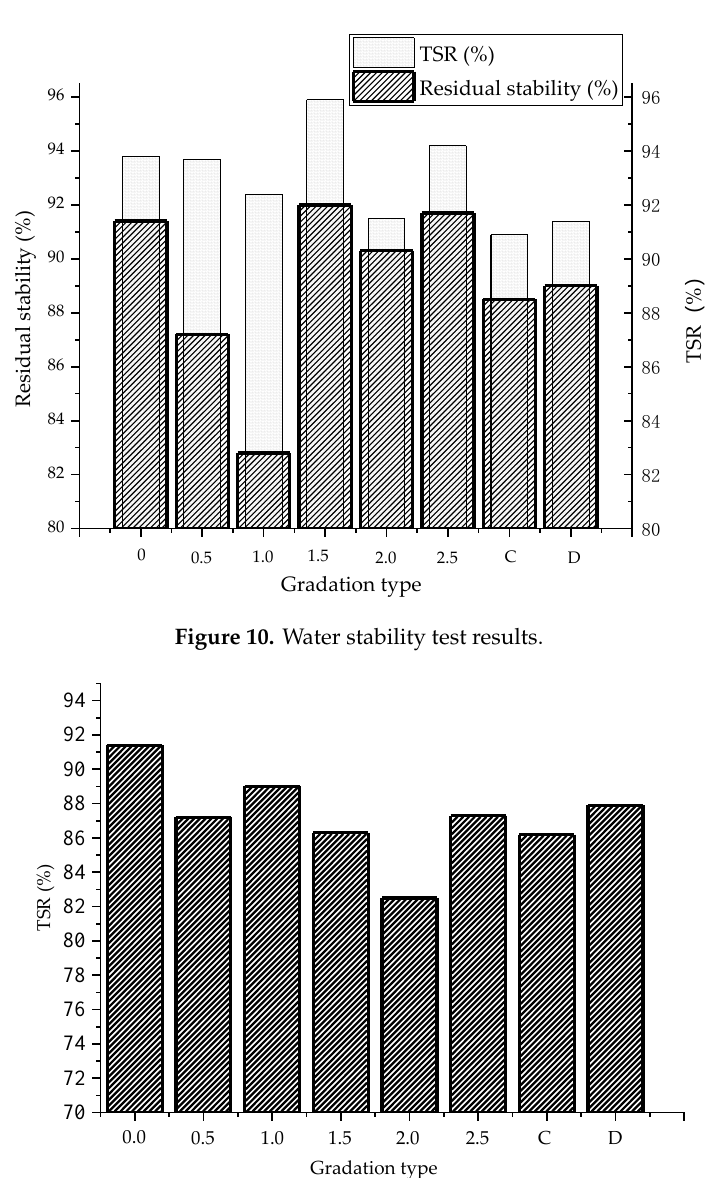
Figure 11. Freeze–thaw split test results (done 34 times).